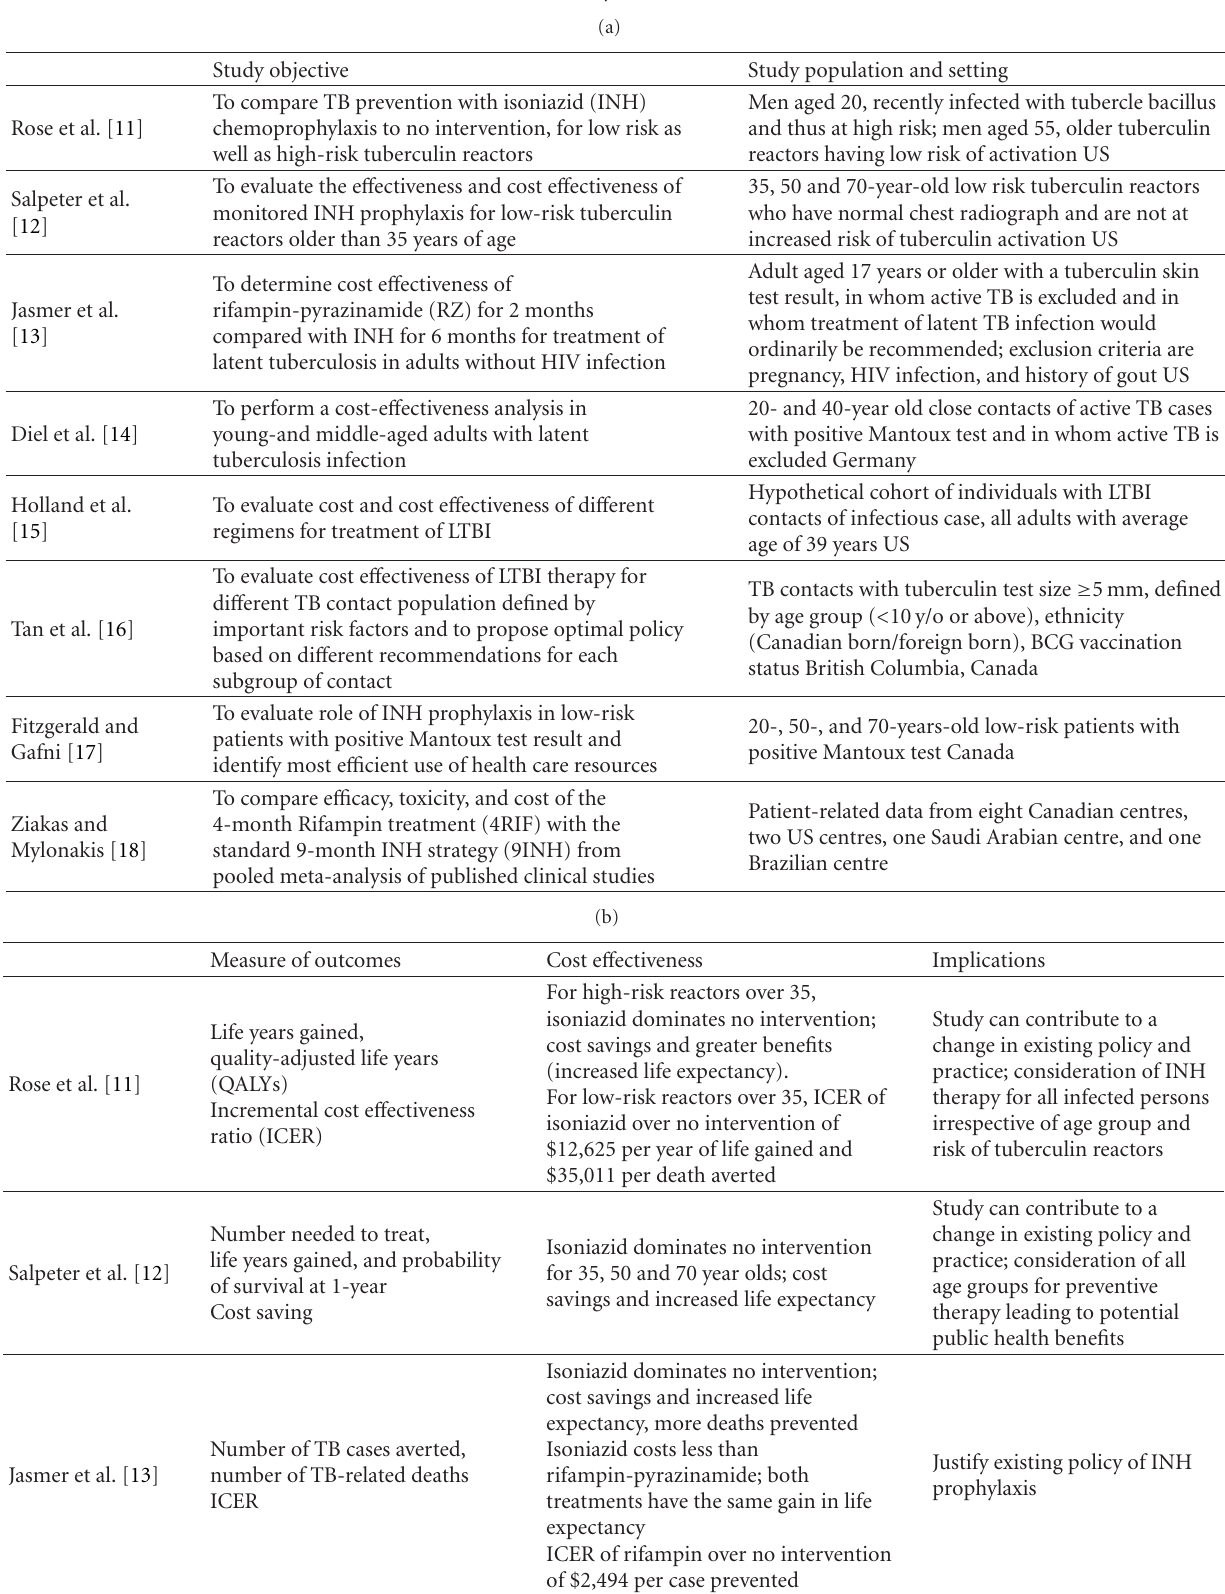
Table 1: Summary of selected